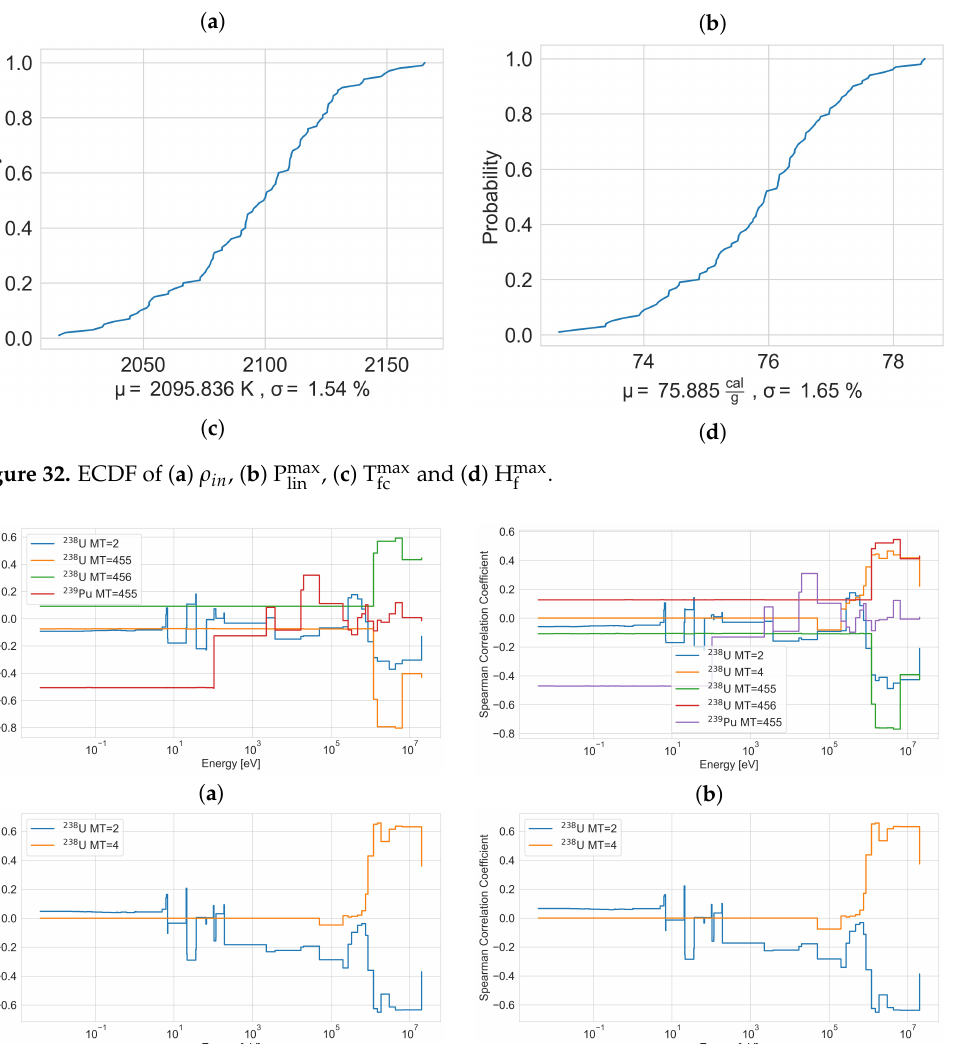
Figure 33. Statistically significant cross-sections Spearman correlation coefficients for ( a ) ρ in , ( b ) P max ( c ) T max and ( d ) H max fc f